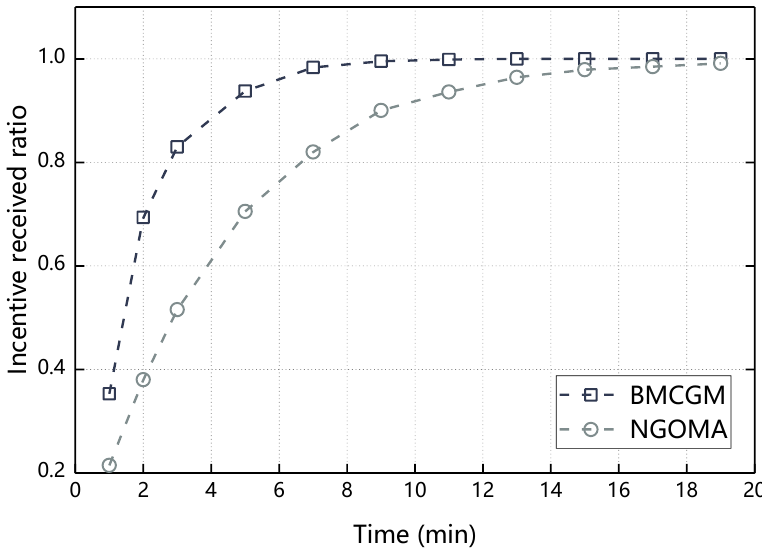
Figure 11. Incentive received ratio with respect to time.